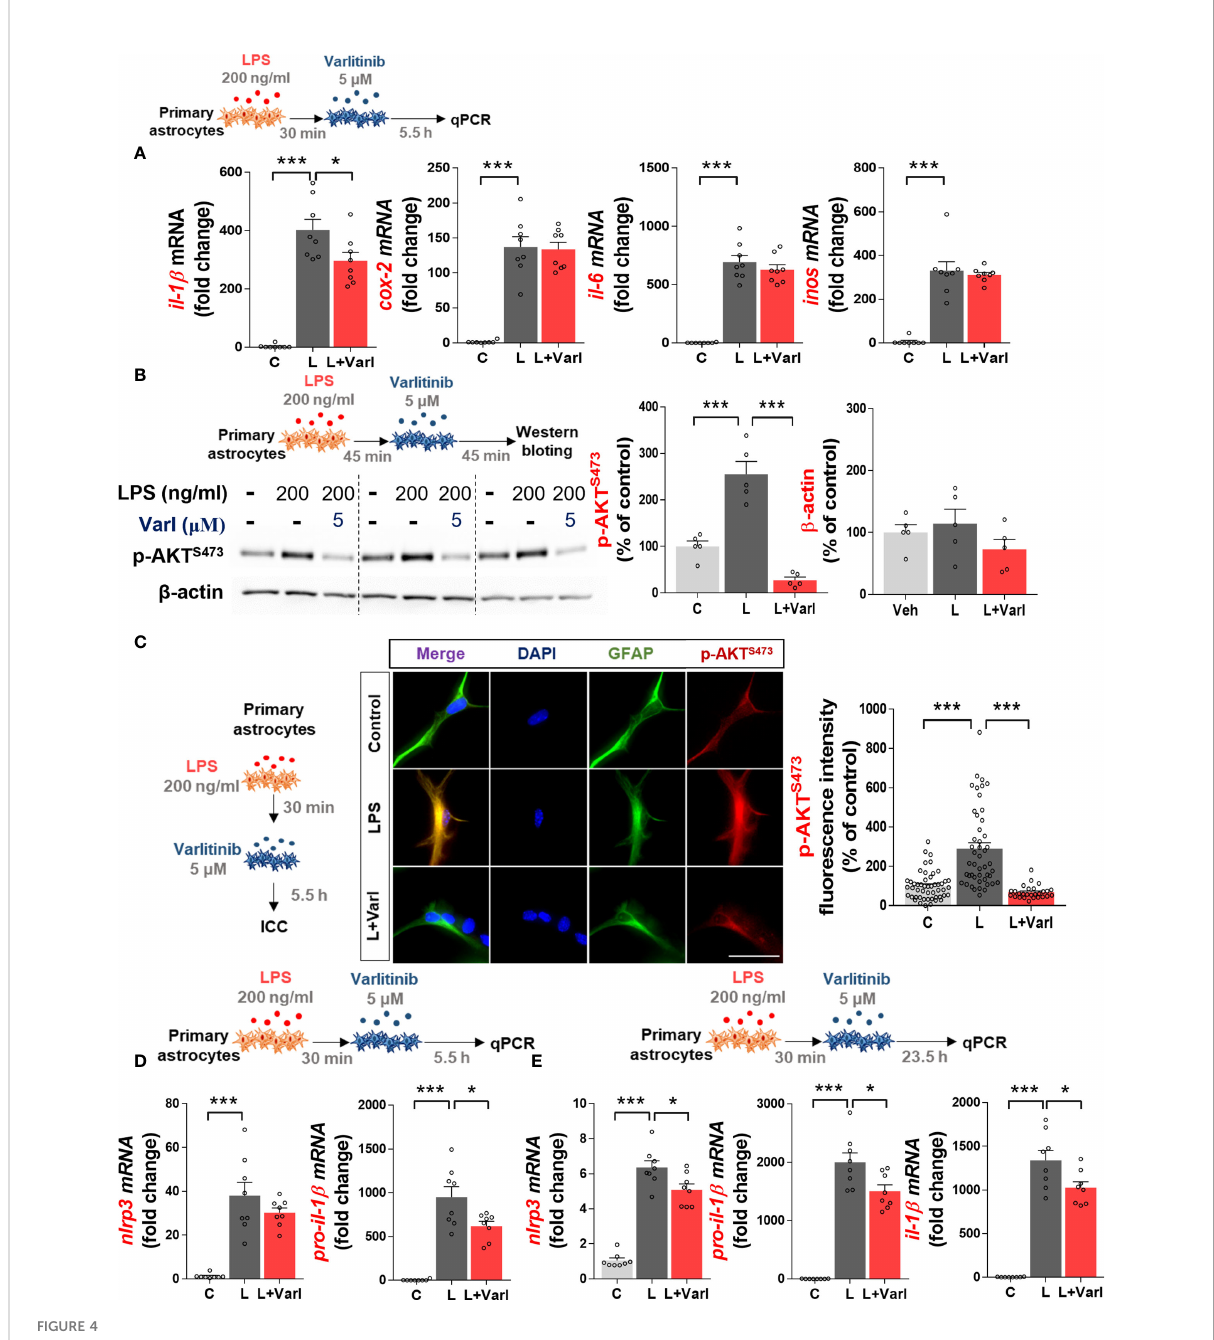
FIGURE 4 Varlitinib reduces LPS-stimulated astroglial il-1 b mRNA levels, AKT signaling, and NLRP3 in fl ammasome activation in mouse primary astrocytes. (A) Cells were treated with LPS (200 ng/ml) or PBS for 30 min and varlitinib (5 m M) or vehicle (1% DMSO) for 5.5 h, and proin fl ammatory cytokine and mediator mRNA levels were measured by real-time PCR ( il-1 b , cox-2, il-6 , and inos : C: n = 8; L: n = 8; L+Varl: n = 8, independent biological replicates). (B) Cells were treated with LPS (200 ng/ml) or PBS for 45 min and varlitinib (5 m M) or vehicle (1% DMSO) for 45 min, and western blotting was conducted with anti-p-AKT and anti- b -actin (C: n = 5; L: n = 5; L+Varl: n = 5, independent biological replicates) antibodies. (C) Cells were treated as in (A) , and immunocytochemistry was conducted with anti-p-AKT and anti-GFAP antibodies (C: n = 50; L: n = 47; L+Varl: n = 27, total number of examined cells). (D) Cells were treated as in (A) , and nlrp3 and pro-il-1 b mRNA levels were measured by real-time PCR ( nlrp3 and pro-il-1 b : C: n = 8; L: n = 8; L+Varl: n = 8, independent biological replicates). (E) Cells were treated with LPS (200 ng/ ml) or PBS for 30 min and varlitinib (5 m M) or vehicle (1% DMSO) for 23.5 h, and the expression of NLRP3 in fl ammasome-associated genes was measured by real-time PCR ( nlrp3, pro-il-1 b , and il-1 b : C, n = 8; L, n = 8; L+Varl: n = 8, independent biological replicates). * p < 0.05, *** p < 0.001, C: Control; L: LPS; L+Varl, LPS+Varlitinib. Scale bar = 20 m